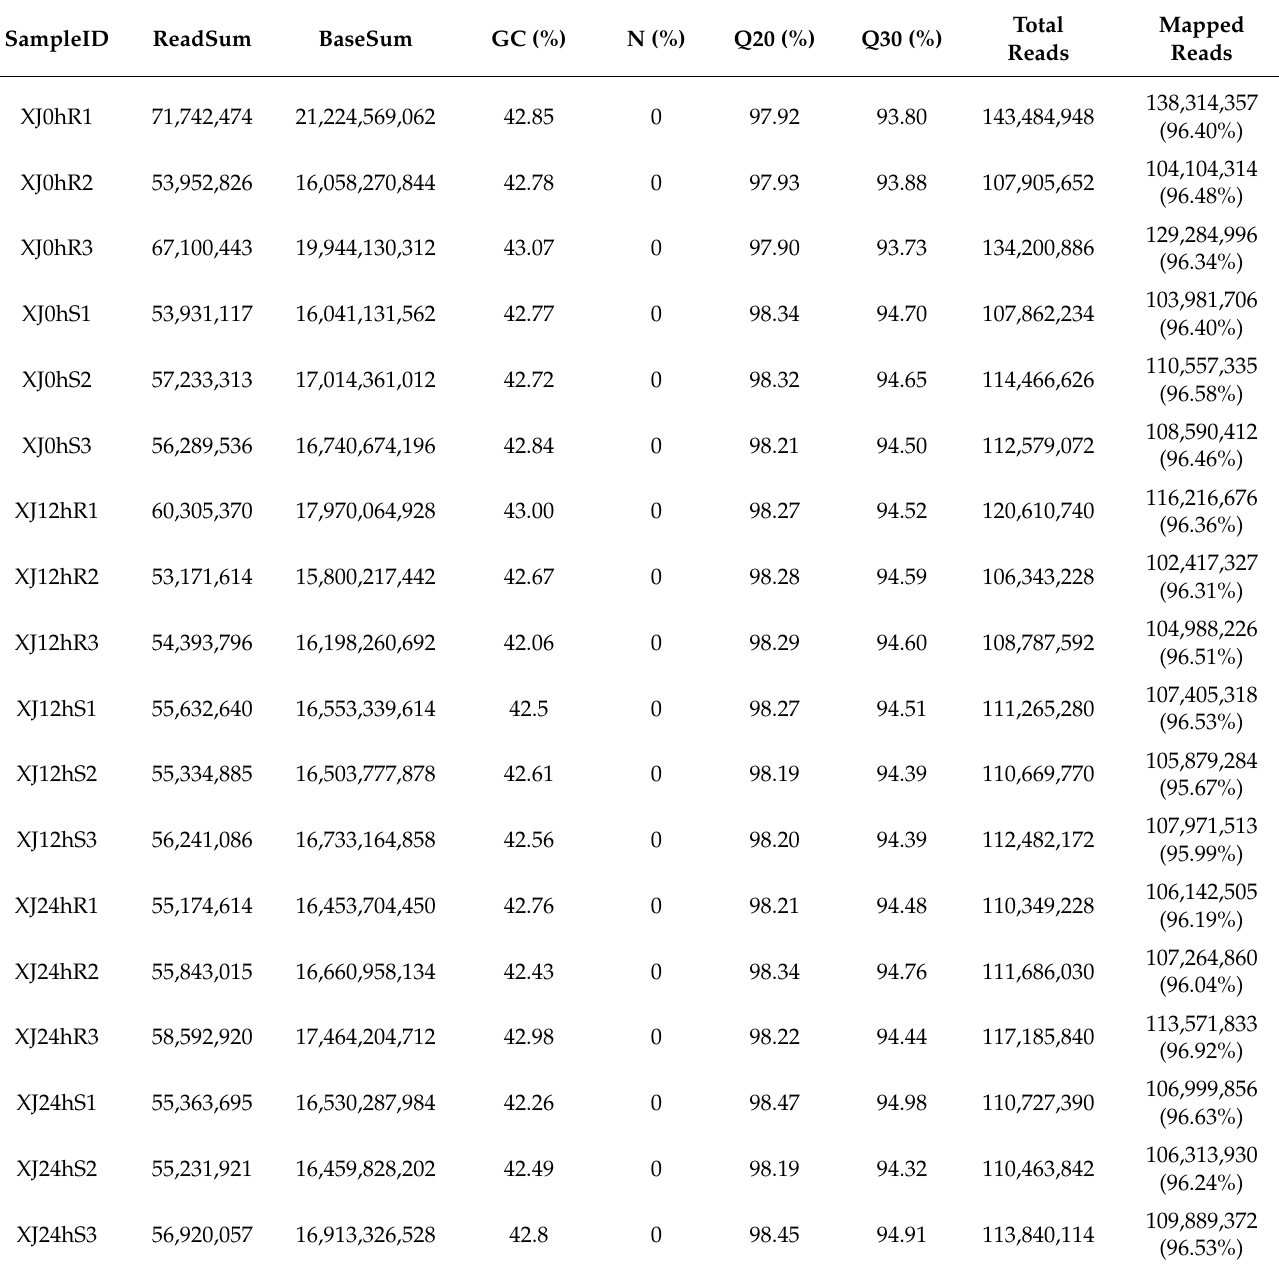
Table 1. Statistical table for the sequencing data